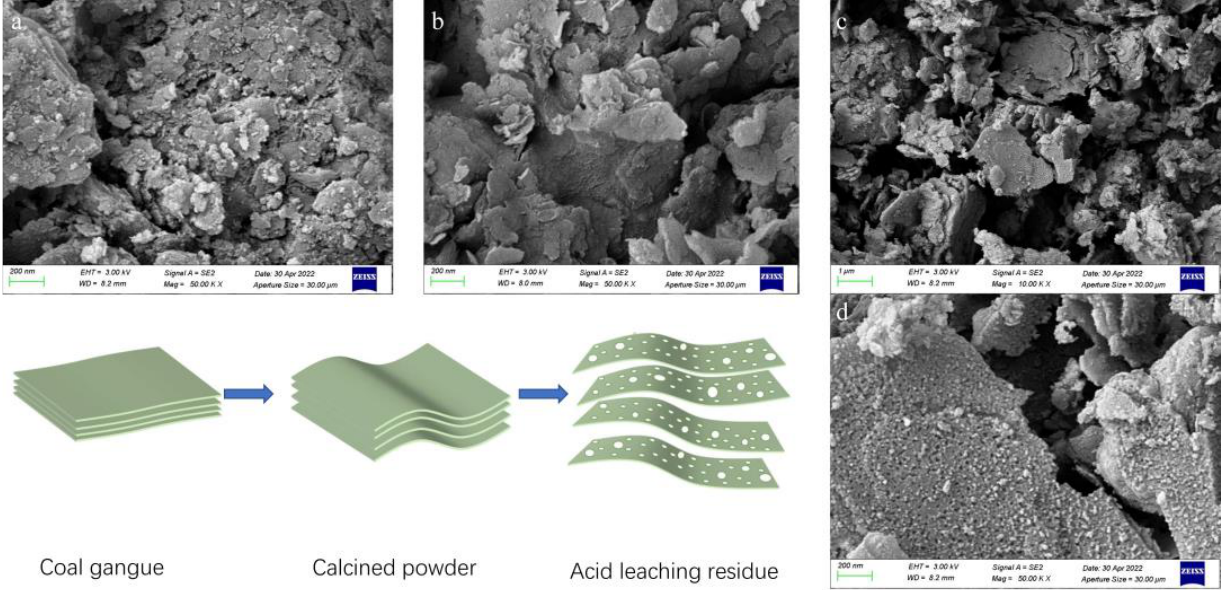
Figure 5. Mechanical diagram of CaF 2 to improve the leaching ratios of aluminum and iron ions. ( a ) is an SEM image of raw coal gangue, ( b ) is an SEM image of calcined powder, ( c ) is an SEM image of acid leaching residue, and ( d ) is an enlarged view of the middle part of ( c ).